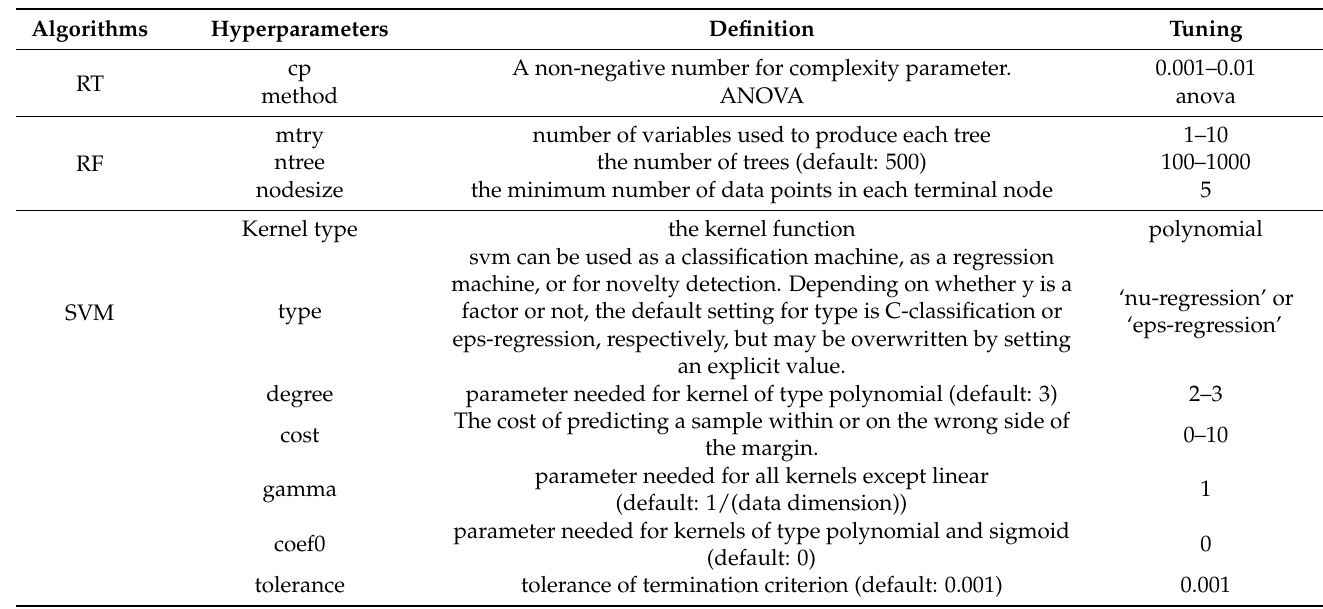
Table 2. Hyperparameters of machine learning algorithms used in this